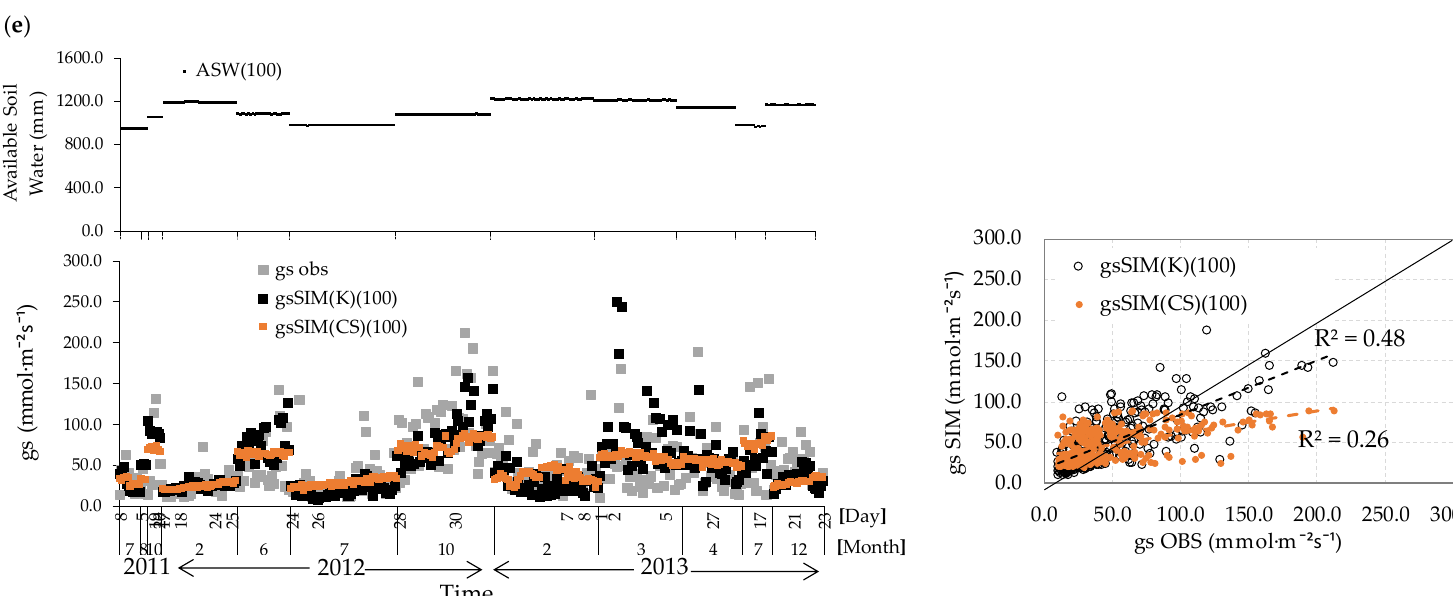
Figure 6. Behavior of the hourly average series for observed (OBS) and simulated (SIM) g s over 42 d with records while considering the seasonal adjustment (K) and the complete series (CS) of the atmospheric variables ( a ) and then for each one ( b – e ), incorporating the analysis of residues ( N ( t ) ) in function of the dynamic regression using REW ( Z i ), where Z i is the depth in the soil at 10, 30, 50, and 100 cm within the root zone. ASW = ( VWC i − VWC PWP ) × Z i , where Z i is the vertical length of the soil horizon. The x-axes indicate time in days, month and year.